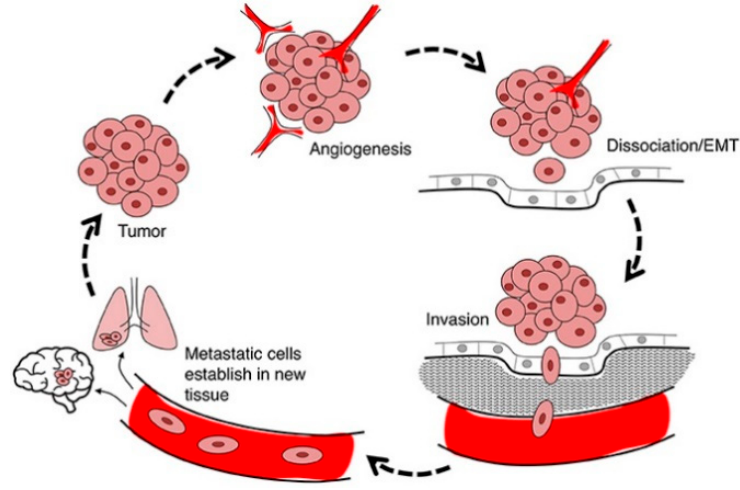
Figure 6. Invasion and Metastasis . Clinically detectable metastases represent the end products of a complex series of cell-biological events, which are collectively termed the invasion-metastasis cascade. During metastatic progression, tumor cells exit their primary sites of growth (local invasion, intravasation), translocate systemically (survival in the circulation, arrest at a distant organ site, extravasation), and adapt to survive and thrive in the foreign microenvironments of distant tissues (micro metastasis formation, metastatic colonization). Reprinted by permission from De Ieso and Yool, 2018 [74].